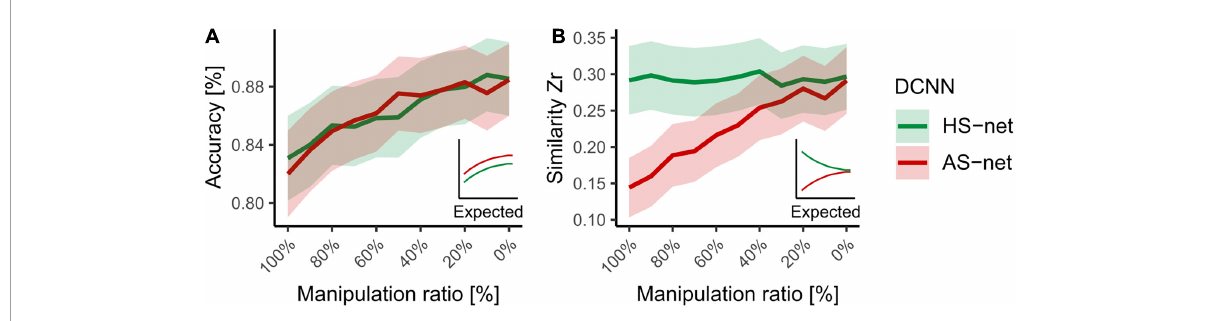
FIGURE6 Accuracy versus similarity trade-off across HS and AS manipulation ratios ranging from 100 to 0% in steps of 10%. (A) Mean object recognition accuracy of DCNN runs for all individual testing images. (B) Mean Fisher’s Z transformed Pearson correlations between DCNN GradCAMs and human eye tracking heatmaps for all individual testing images. Shaded areas display bootstrap confidence